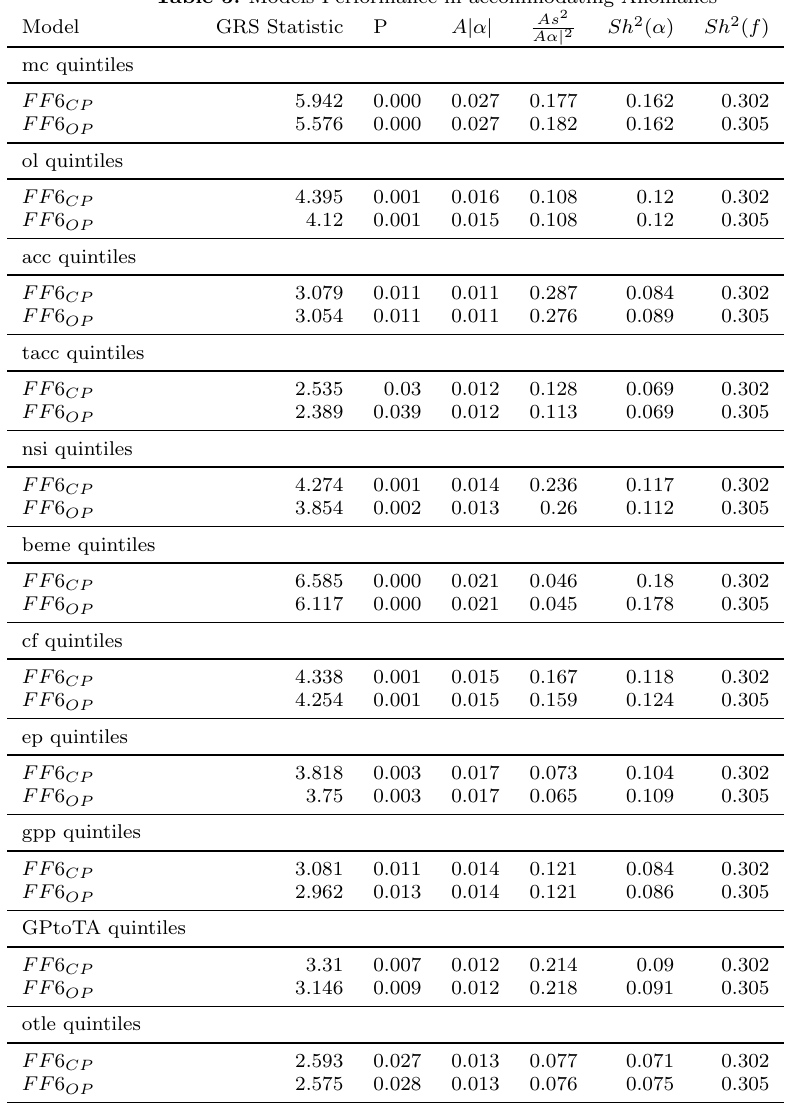
Table 5: Models Performance in accommodating